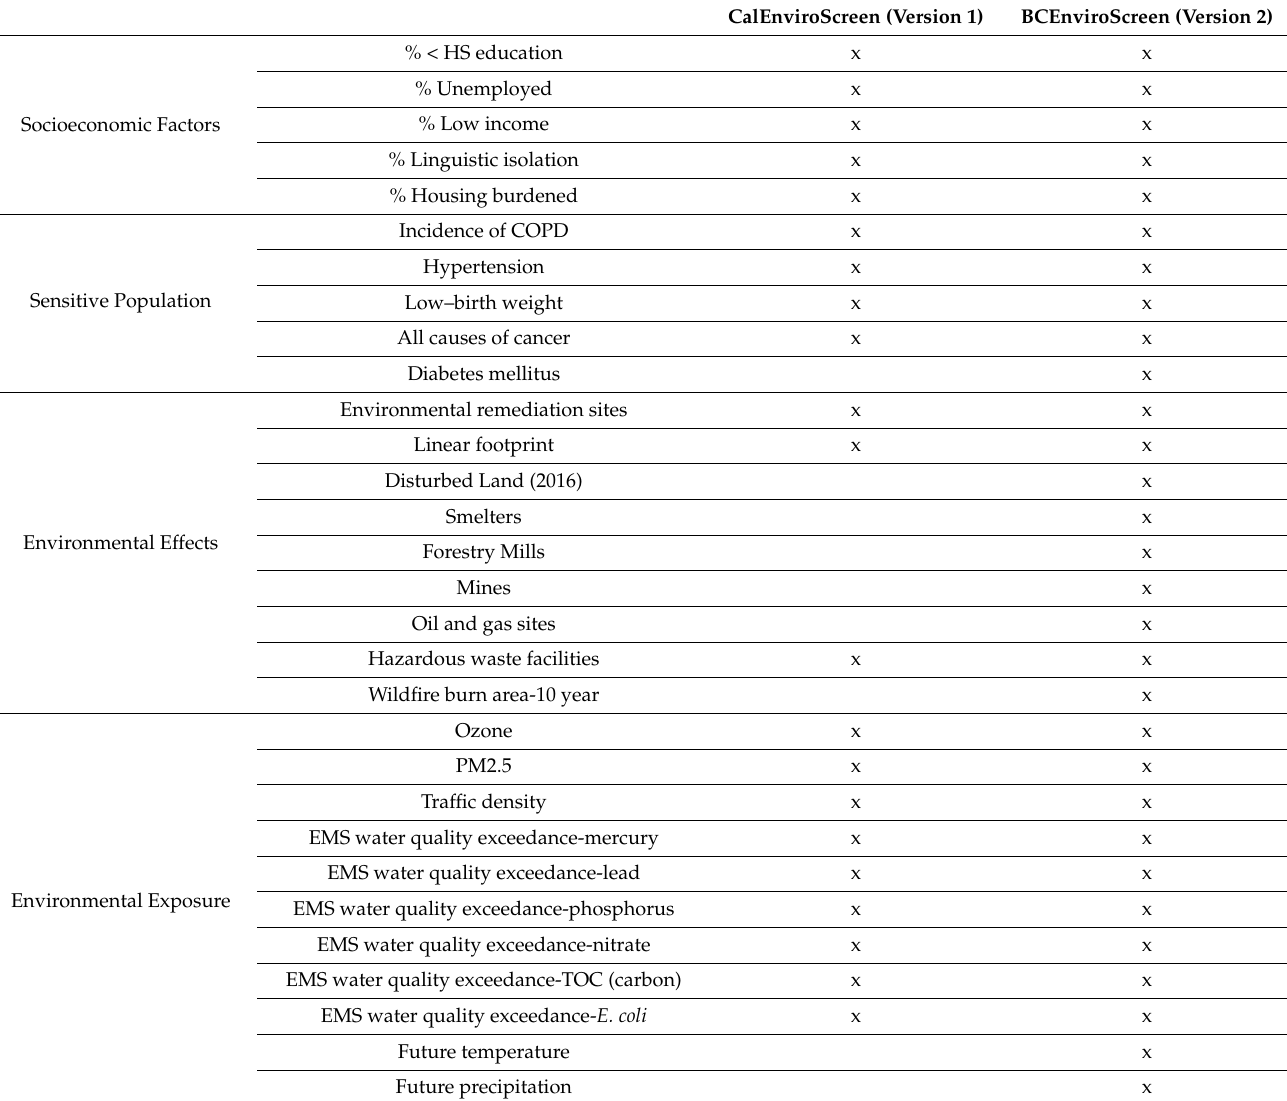
Table 2. Indicator comparison between Version 1 (CalEnviroScreen) and Version 2 (BCEnviroScreen) of the EnviroScreen methodology applied to British Columbia,